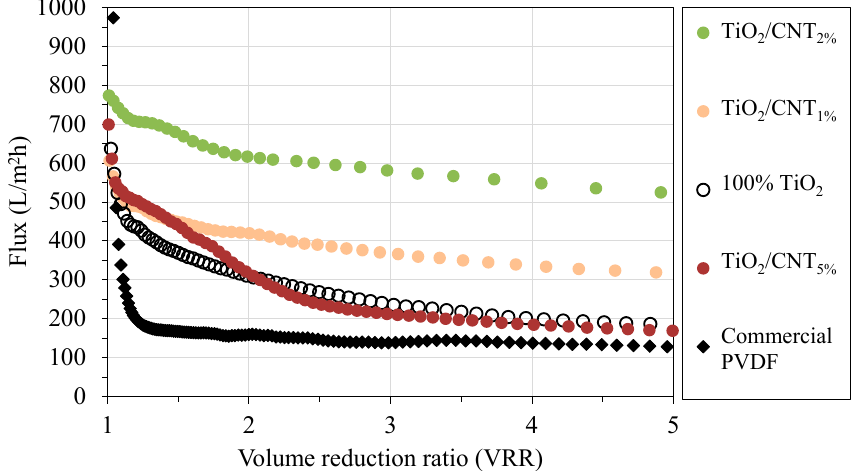
Figure 2. Flux values recorded during the filtration of oil emulsions at a 0.1 MPa transmembrane pressure.